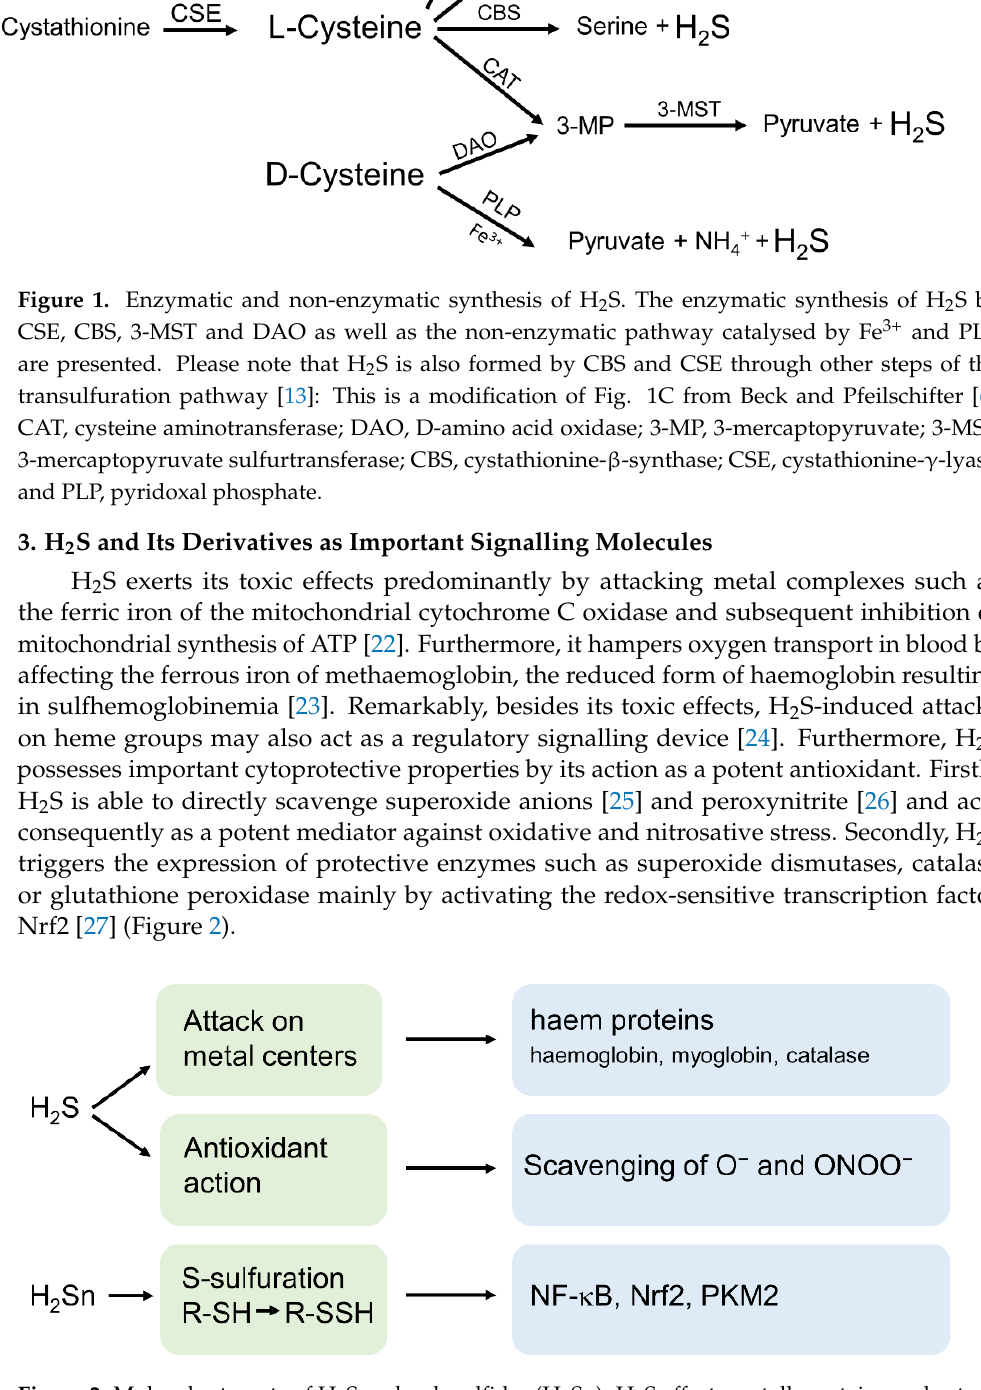
Figure 2. Molecular targets of H 2 S and polysulfides (H 2 Sn). H 2 S affects metalloproteins and acts as a scavenger of superoxide anion (O 2 − ) and peroxynitrite (ONOO − ). H 2 Sn is the most important mediator of S-sulfuration of cysteine thiols. NF-kB, Nuclear factor kappa-light-chain-enhancer of activated B-cells; Nrf2, Nuclear factor erythroid 2-related factor 2; PKM2, pyruvate kinase